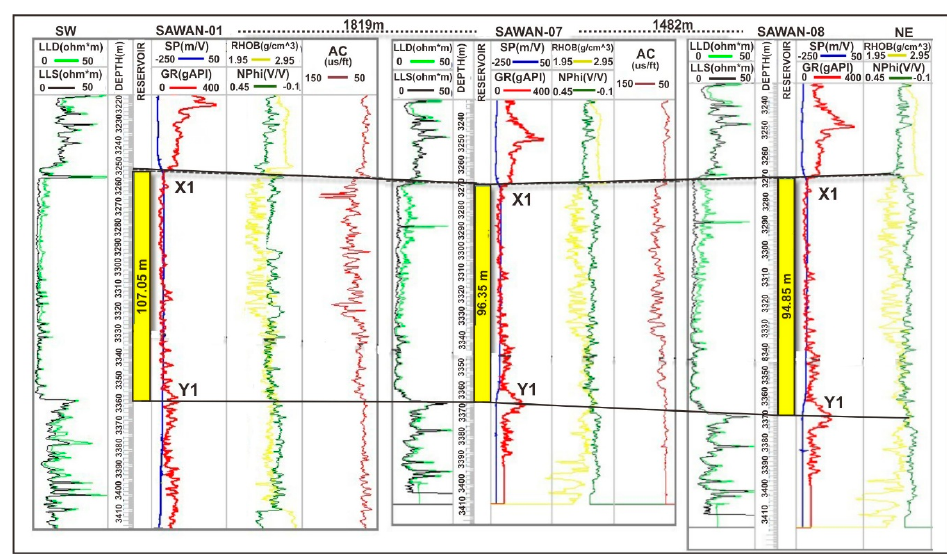
Figure 5. Stratigraphic correlation of study wells showing the thicknesses of ZOI in the study area.